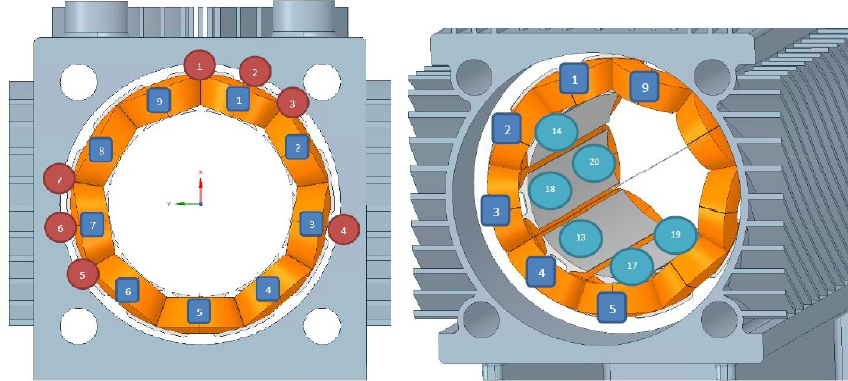
Figure 16. Position of the thermo-couples in the model.